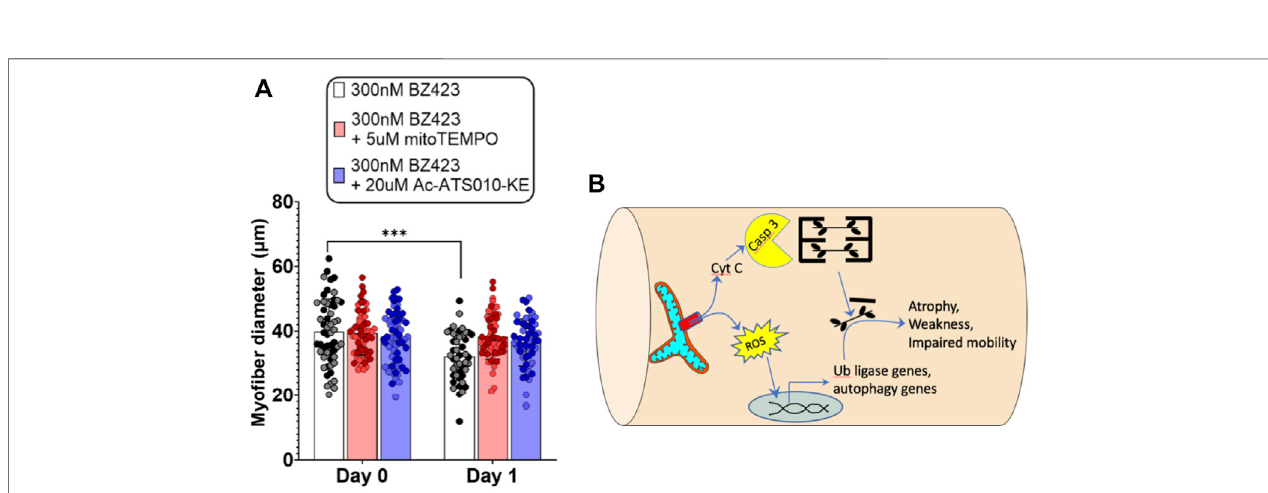
FIGURE 3 | Recent evidence identi fi es mitochondrial permeability transition (MPT) as a mechanism that induces skeletal muscle atrophy in a mitochondrial ROS- and Caspase 3-dependent manner (Burke et al., 2021). (A) Single FDB muscle fi bers from adult mice treated with Bz423 (to induce MPT) for 24 h demonstrated signi fi cant atrophy that could be prevented by inhibiting mitochondrial ROS using mitoTemo or by inhibiting caspase 3 using Ac-ATS010-KE ( fi gure panel adapted from (Burkeetal.,2021)). (B) SchematicillustrationshowinghowMPT-inducedreleaseofcytochromeCleadstoactivationofcaspase3thatinturnleadstocleavageof actin from the muscle cross-bridges, and release of ROS that activates ubiquitin ligase and autophagy signaling to promote muscle atrophy.